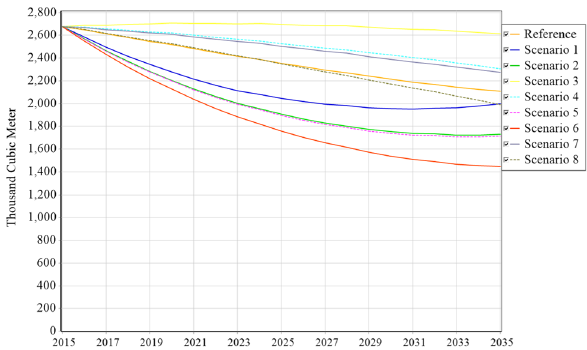
Fig. 5 Changes in water shortage from 2015 to 2035